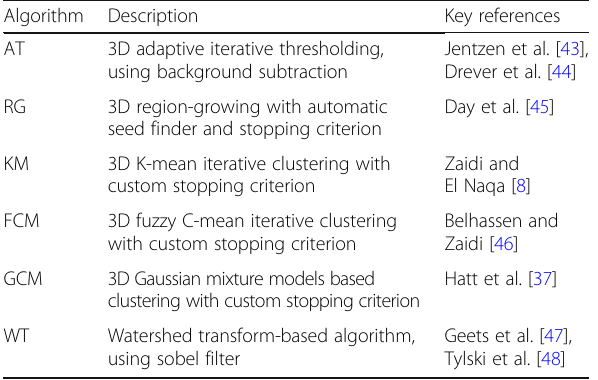
Table 1 Name and description of PET-AS methods used in this study, with references of published work using similar segmentation approaches Algorithm